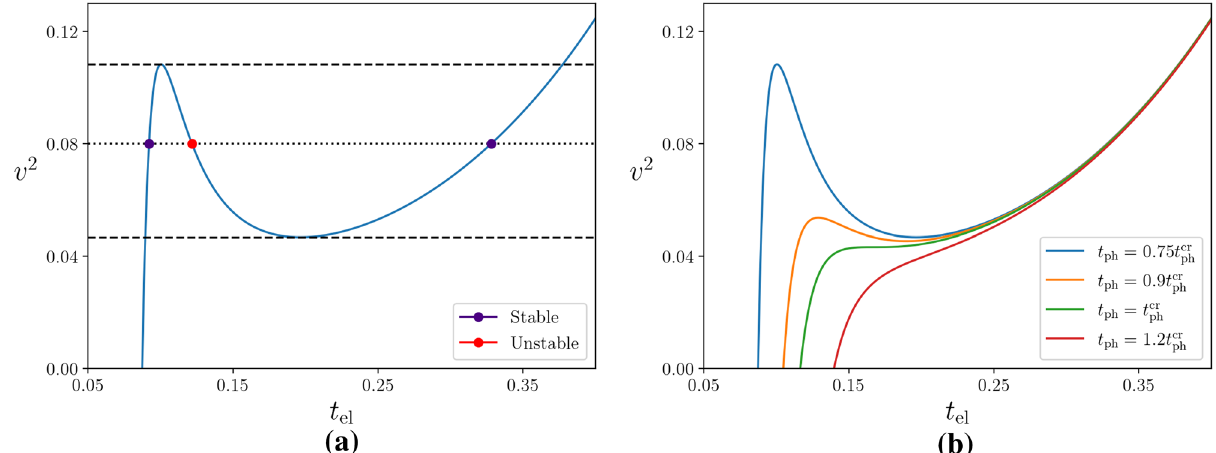
Figure 1. (a) The bistability region, where two stable solutions for t el exist in a certain range of the applied voltage, is shown for t ph = 0.75 t cr ph for the Arrhenius equilibrium resistance, γ = 1 . The blue dots correspond to cold and hot electron states at temperatures t < el and t > el , respectively, and the red dot to an unstable solution. (b) The dependence of t el on v 2 for different phonon bath temperatures is shown as follows from Eq. (7). Above the critical bath temperature this corresponds to the actual t el ( v ) dependence while below t cr ph the electronic system will fall either to t < el or to t > el , making temperatures in between experimentally